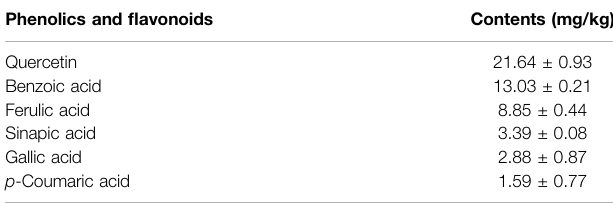
TABLE 1 | Total phenolic content and total fl avonoid content (mg/g) of Moringa oleifera leaf extract. Maturity stage